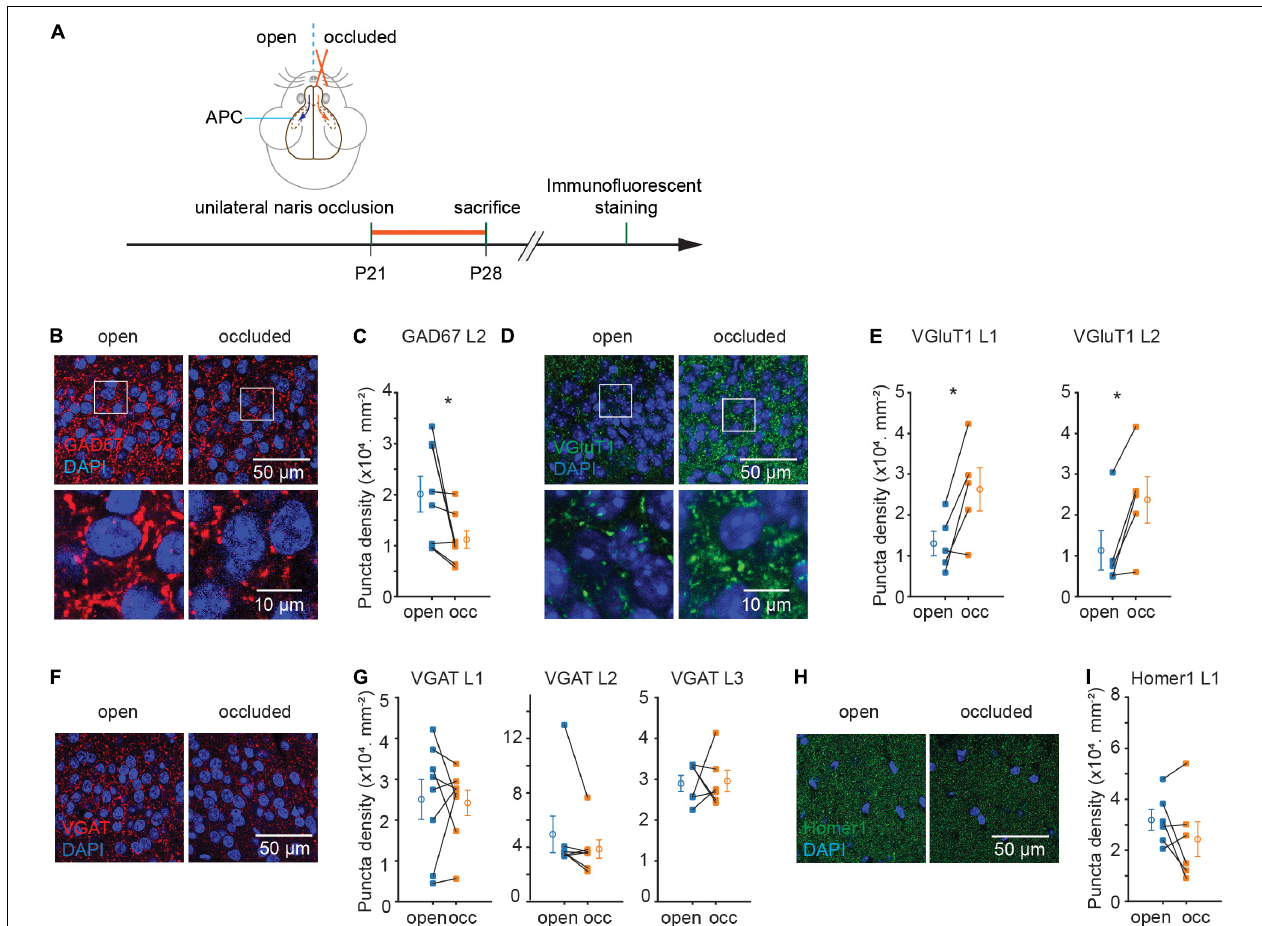
FIGURE 1 | Sensory deprivation induced structural plasticity of excitatory and inhibitory synapses in anterior piriform cortex (APC). (A) Timeline of experiment. Unilateral naris occlusion was performed in P21 wild type mice. 7 days after naris occlusion, mice were sacrificed for further immunostaining. (B) Representative images of GAD67 puncta in layer 2 of APC. (C) Quantification of GAD67 puncta density in layer 2 of APC ( p = 0.04, N = 8). (D) Representative images of VGluT1 puncta in layer 2 side of APC. (E) Quantification of VGluT1 puncta density in layer 1 and layer 2 of APC. (L1: p = 0.03, N = 5; L2: p = 0.02, N = 5). (F) Representative images of VGAT puncta in layer2 of APC. (G) Quantification of VGAT puncta density in APC (L1: p = 0.84, N = 8; L2: p = 0.22, N = 7; L3: p = 0.87, N = 6). (H) Representative images of Homer1 puncta in layer 1 of APC. (I) Quantification of Homer1 puncta density in layer 1 of APC ( p = 0.23, N = 6). N-number